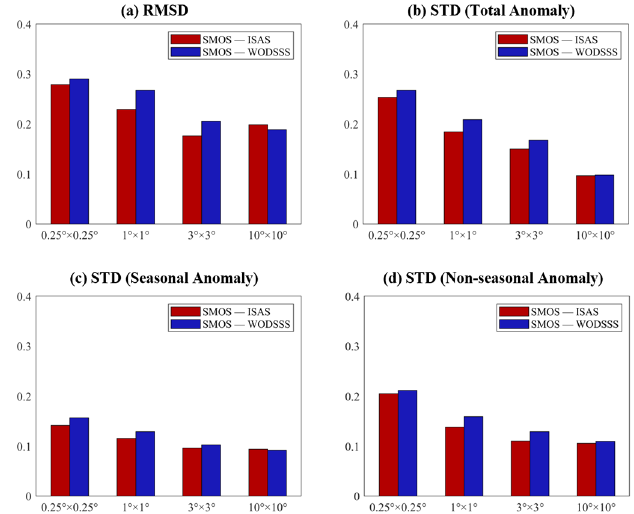
Figure 10. ( a ) Global average of temporal RMSD values between SMOS BEC L3 product and two in situ analyzed SSS products on four spatial scales indicated by legends along the horizontal axis. Global average of temporal STD values for the differences between SMOS BEC L3 product and two in situ analyzed SSS products on four different spatial scales for ( b ) total anomaly, ( c ) seasonal anomaly and ( d ) non-seasonal anomaly. RMSD and STD values are in the unit of PSU.